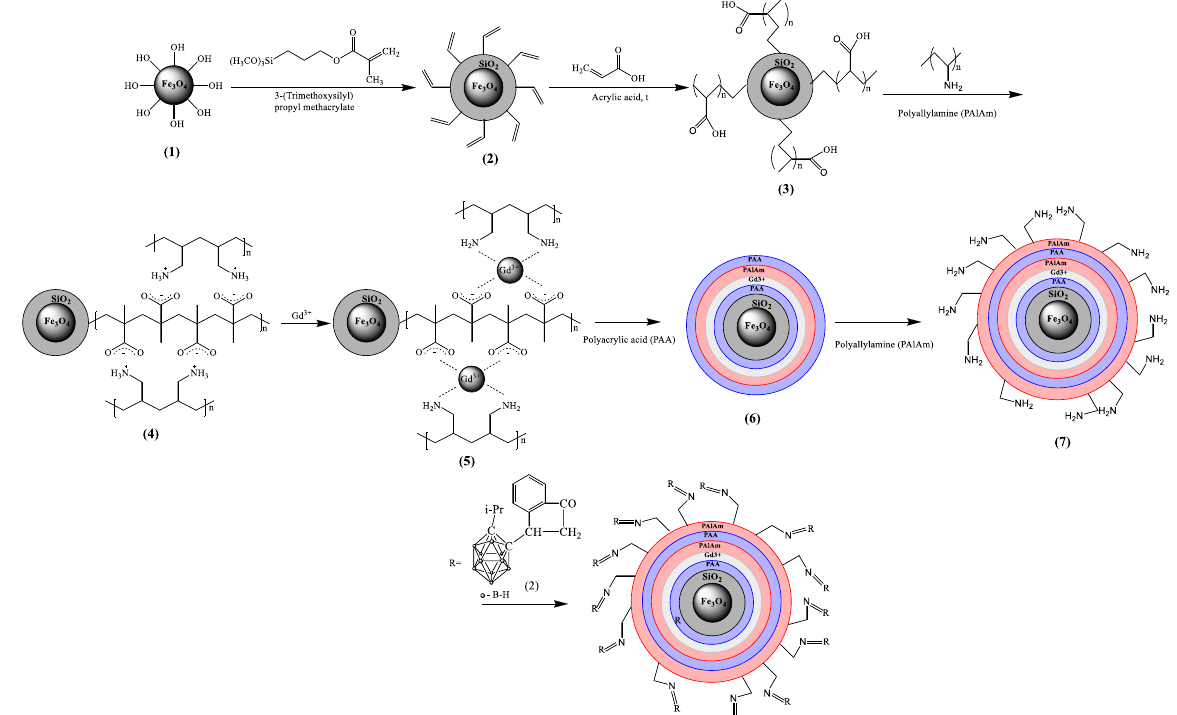
Figure 2. SEM images of Fe 3 O 4 ( a ), Fe 3 O 4 -TMSPM ( b ), Fe 3 O 4 -TMSPM-PAA ( c ), Fe 3 O 4 -TMSPM- PAA/PALAm ( d ), Fe 3 O 4 -TMSPM-PAA/PALAm-Gd ( e ).